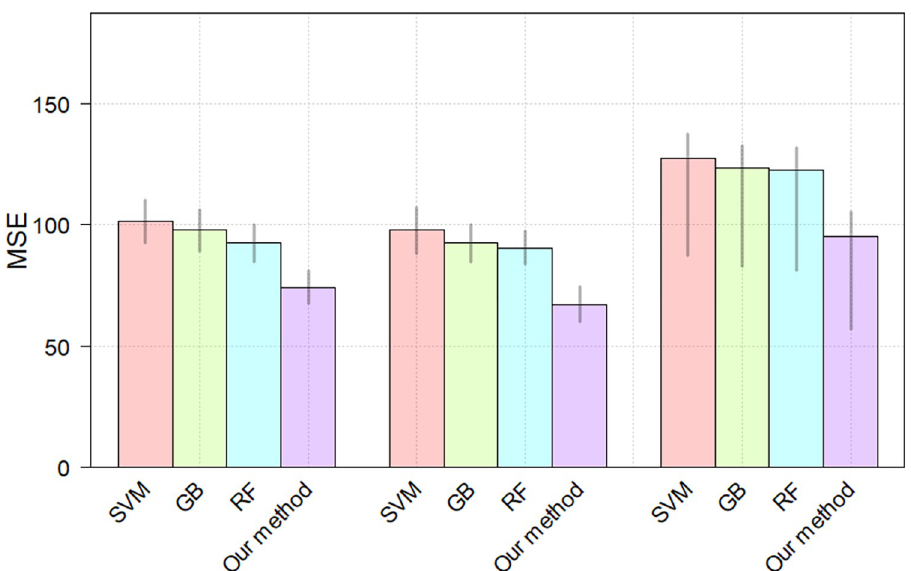
Fig 9. The MSEs of different methods. The heights of the bars denote the means, gray lines denote the 95% confidence intervals.